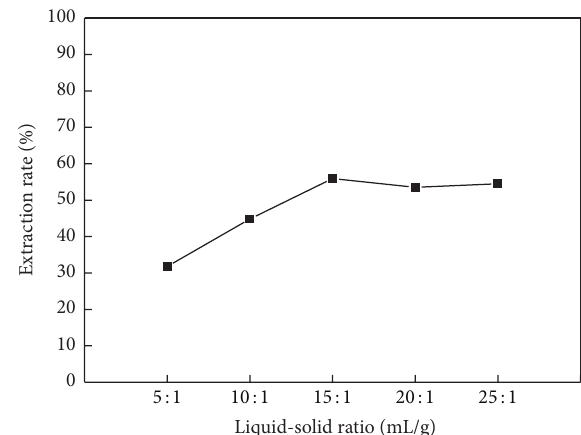
Figure 2: Effect of liquid-solid ratio on the extraction rate of saponin (alkali solution pH value 10mL/g, extraction temperature 60 ∘ C, extraction time 60 min, and acid isolation pH value